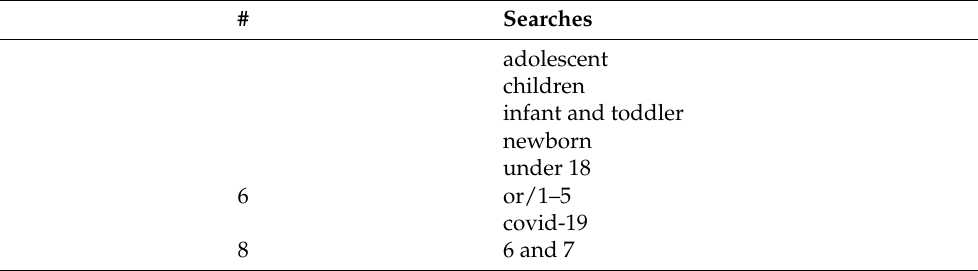
Table A8. Search strategy.